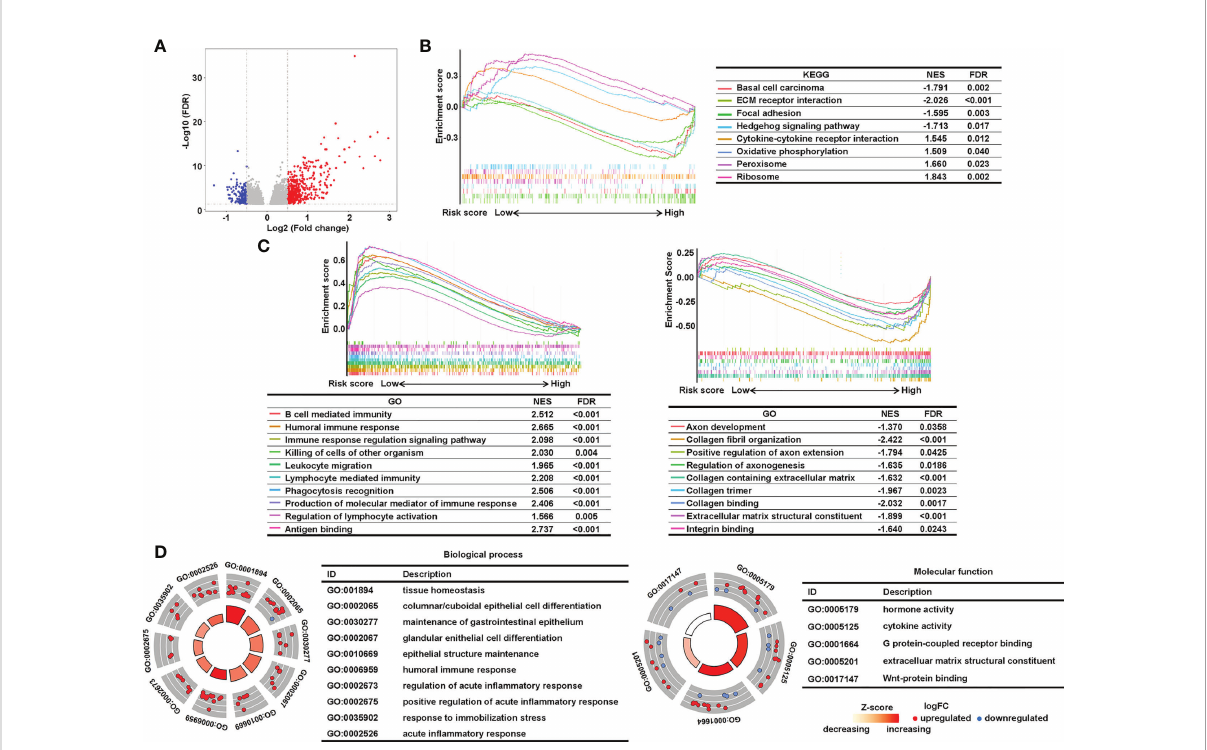
FIGURE 7 Analysis of underlying biological pathways of the sialylation-related lncRNA signature. (A) Volcano plot of differentially expressed genes in the high- and low-risk cohorts with a threshold of FDR > 0.05 and absolute log2(FC) > 0.5. Upregulated pathways enriched in the low-risk group (NES > 1) and the high-risk group (NES< 1) of KEGG (B) and GO (C) with FDR< 0.05. (D) GO enrichment of differentially expressed genes. FC, fold change; FDR, false discovery rate; and NES, normalized enrichment